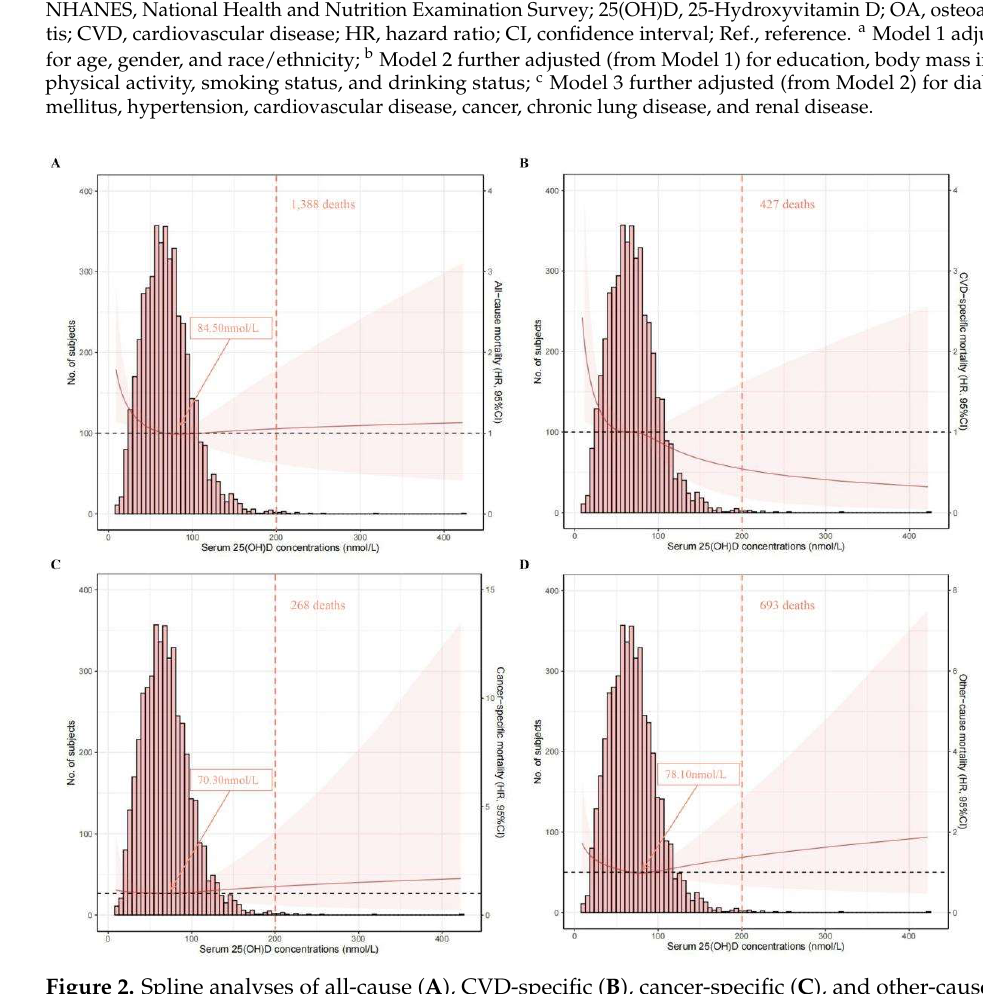
Figure 2. Spline analyses of all-cause ( A ), CVD-specific ( B ), cancer-specific ( C ), and other-cause ( D ) mortality according to serum 25(OH)D concentrations, with the frequency distribution histogram in the background. Solid red lines represent multivariable-adjusted hazard ratios, with light-red areas showing the 95% confidence intervals derived from restricted cubic spline regressions (spline analyses were adjusted for age, gender, race/ethnicity, education, body mass index, physical activity, smoking status, drinking status, diabetes mellitus, hypertension, cardiovascular disease, cancer, chronic lung disease, and renal disease); arrows indicate the concentration of 25(OH)D with the lowest risk of mortality; over 99% of the participants were located to the left of the red dotted lines. Table 2. After multivariable adjustment, categories with higher levels of 25(OH)D were significantly related to low all-cause mortality and CVD mortality but not to cancer-spe- cific mortality. The multivariable-adjusted HRs (95% CIs) across four categories of serum 25(OH)D concentrations were 1.00 (reference), 0.49 (0.31, 0.75), 0.45 (0.29, 0.68), and 0.43 (0.27, 0.69) for all-cause mortality and 1.00 (reference), 0.28 (0.14, 0.59), 0.25 (0.12, 0.51), and 0.24 (0.11, 0.49) for CVD-specific mortality. Table 2. HRs (95% CIs) for all-cause and cause-specific mortality according to serum 25(OH)D con- centrations among OA patients in NHANES III and NHANES 2001–2018. Serum 25(OH)D Concentrations (nmol/L) Per One-Unit Increment in Natural Log-Transformed 25(OH)D <25.0